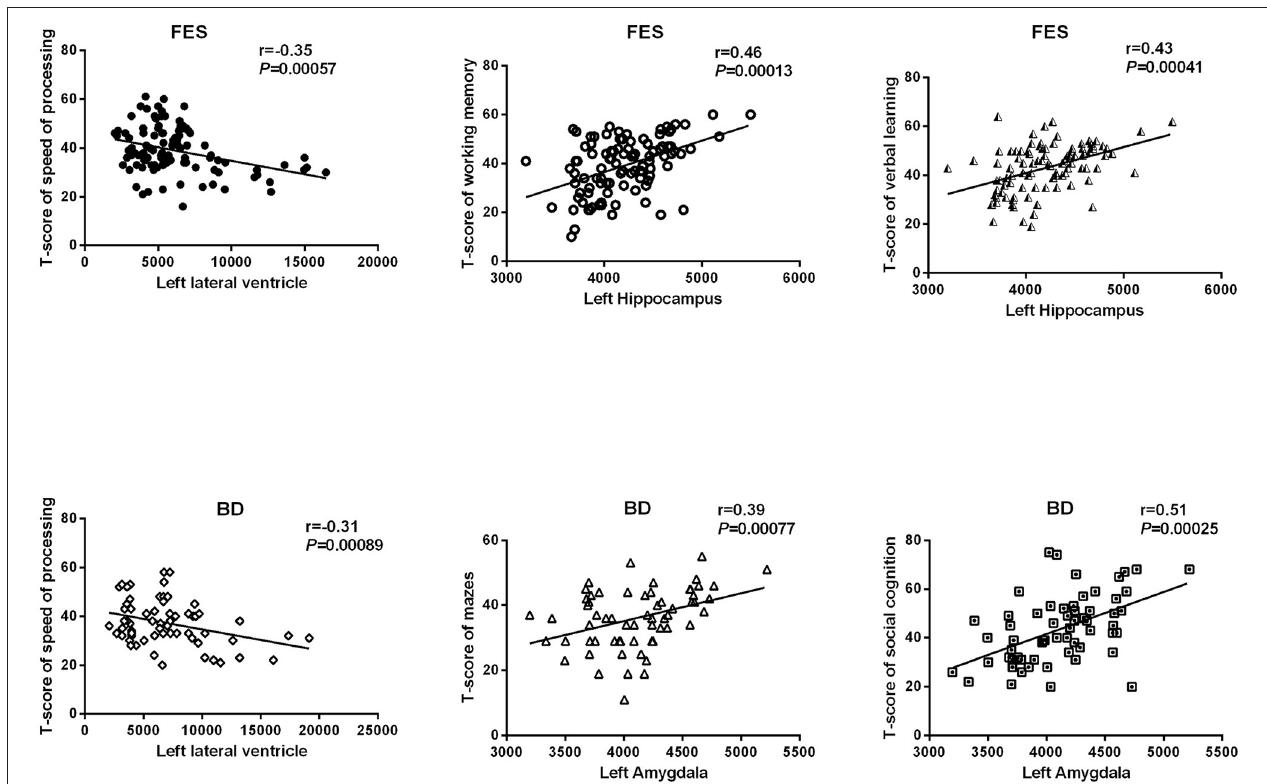
FIGURE 3 | Relationships between subcortical volumes and neurocognition. FES, first episode schizophrenia; BD, bipolar disorder.